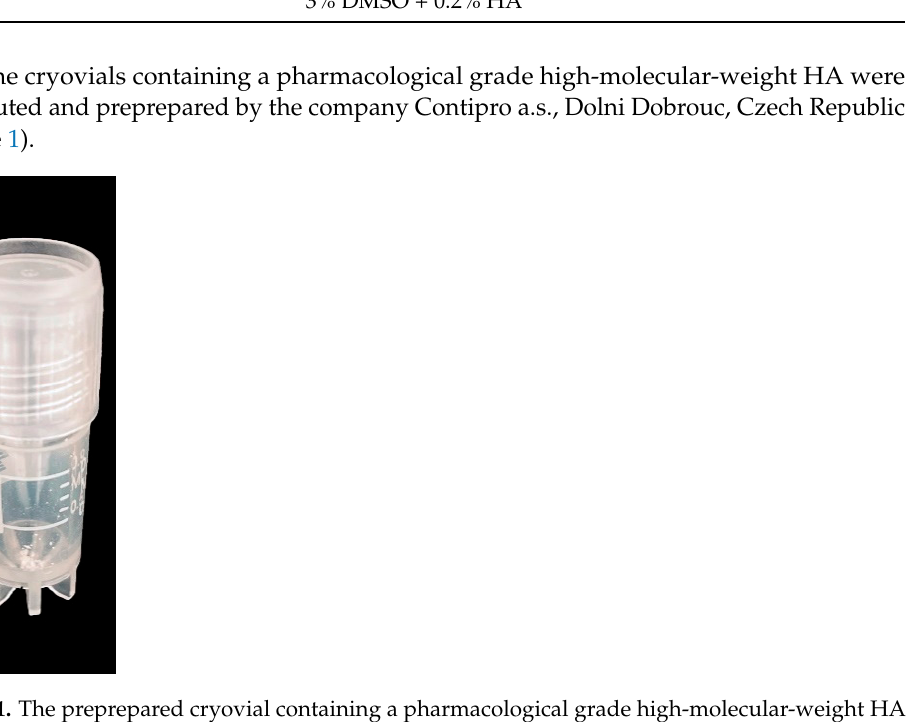
Table 1. Overview of CPA specifications used during uncontrolled-rate freezing of DPSCs.